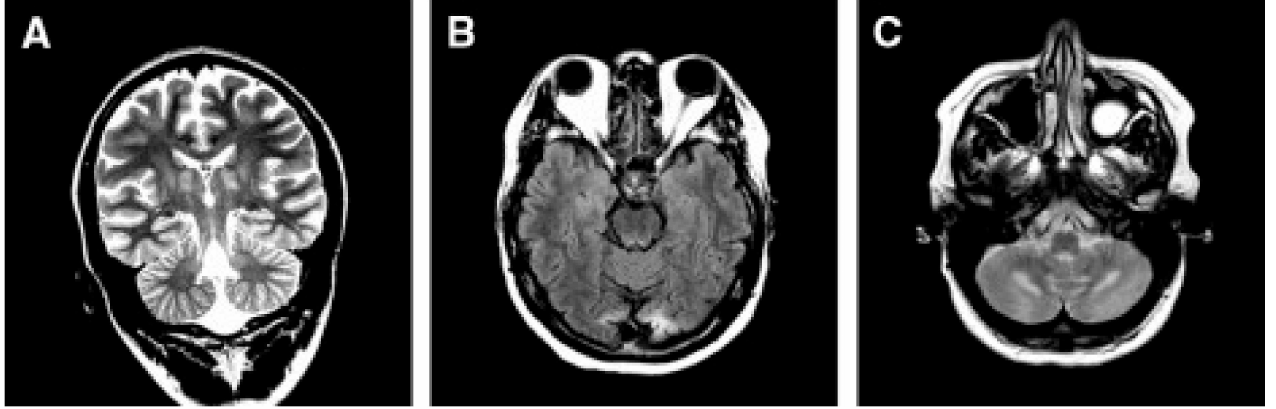
Figure 9. Brain MRI in SCAE. ( A ) Occipital pole lesion; ( B ) multiple lesions in cerebral cortical, subcortical, and thalamic areas; ( C ) bilateral lesions in the central cerebellar white matter. Adapted from